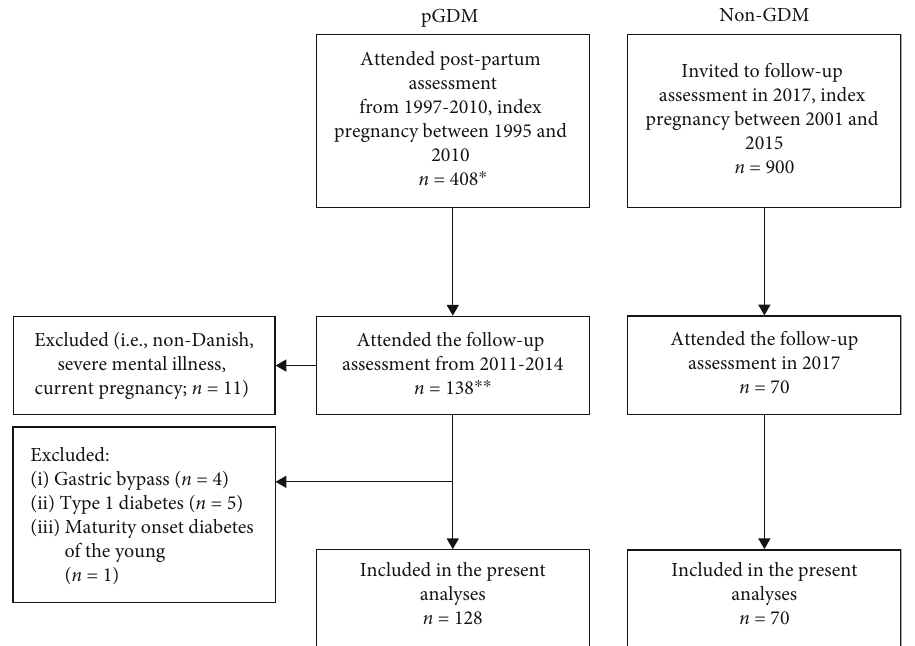
Figure 1: Flow chart of the inclusion procedure. GDM: gestational diabetes mellitus; pGDM: previous GDM; Non-GDM: women without GDM. ∗ A previous paper based on this by Lundberg et al. [21] reported clinical outcomes and glutamic acid decarboxylase (GAD) antibody status in 407 women undergoing a postpartum oral glucose tolerance test during 1997-2010. In the present follow-up study, one additional woman was included as she had a pregnancy complicated by GDM during 1995-1997. ∗∗ Three women attending the follow-up assessment did not participate in the postpartum